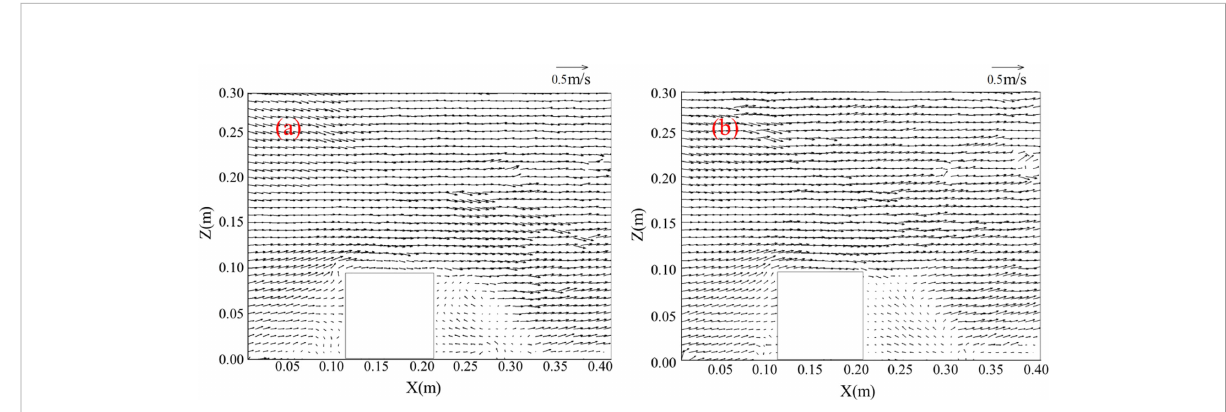
FIGURE 5 Flow fi eld diagram of (A) Fluent simulation and (B) PIV experiment for solid cubic AR at a velocity of 0.18